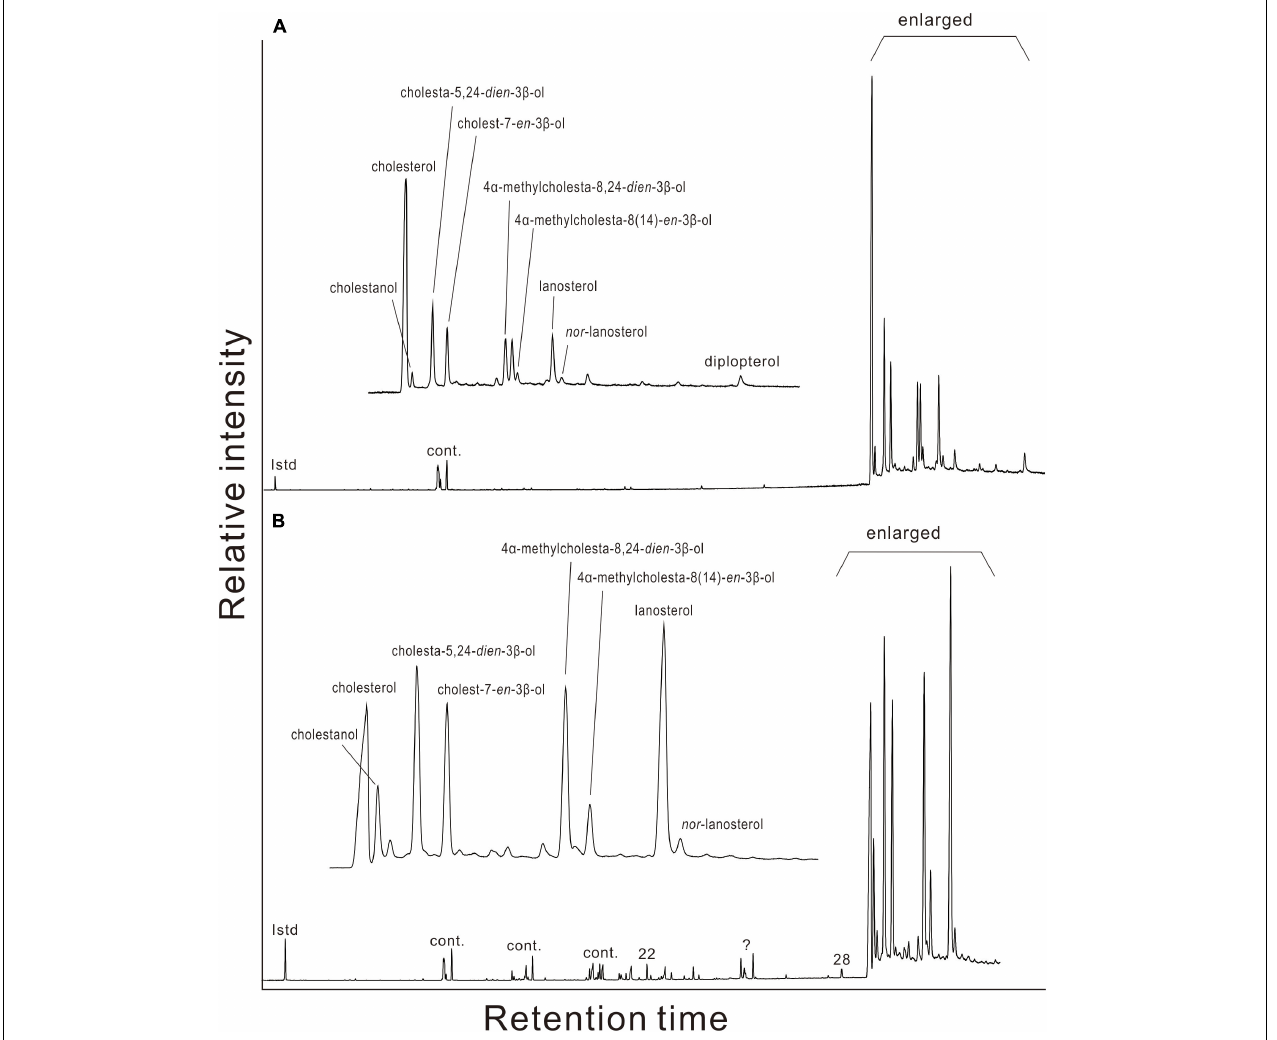
FIGURE 5 | Gas chromatograms of alcohols in gill tissues of (A) Gigantidas platifrons and (B) Gigantidas haimaensis . Roman numerals indicate n -alcohols; ? denotes presently unknown; Cont. =